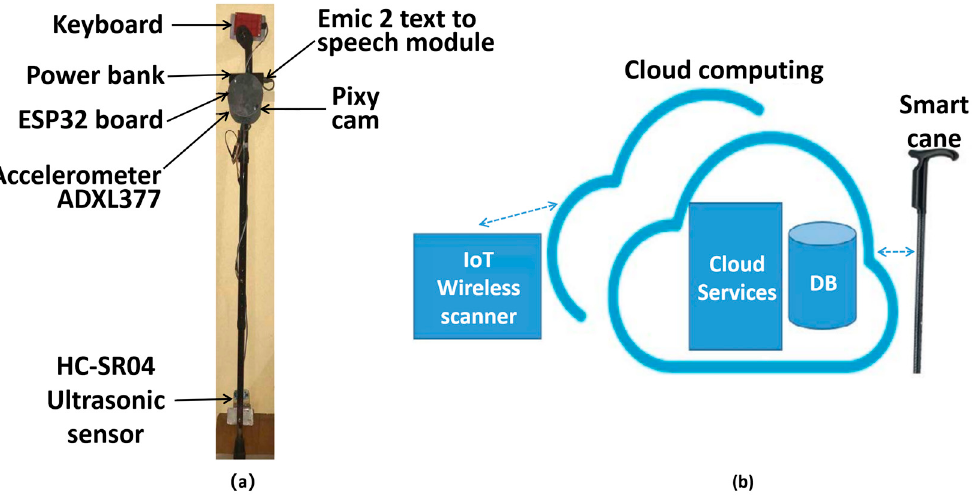
Figure 4. ( a ) The components of the Smart Cane; ( b ) The system structure of smart cane